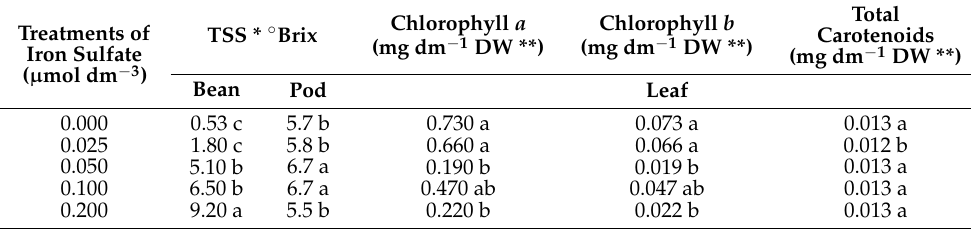
Table 3. Average of the variables total soluble solids (TSS), chlorophyll a , chlorophyll b , and carotenoids.